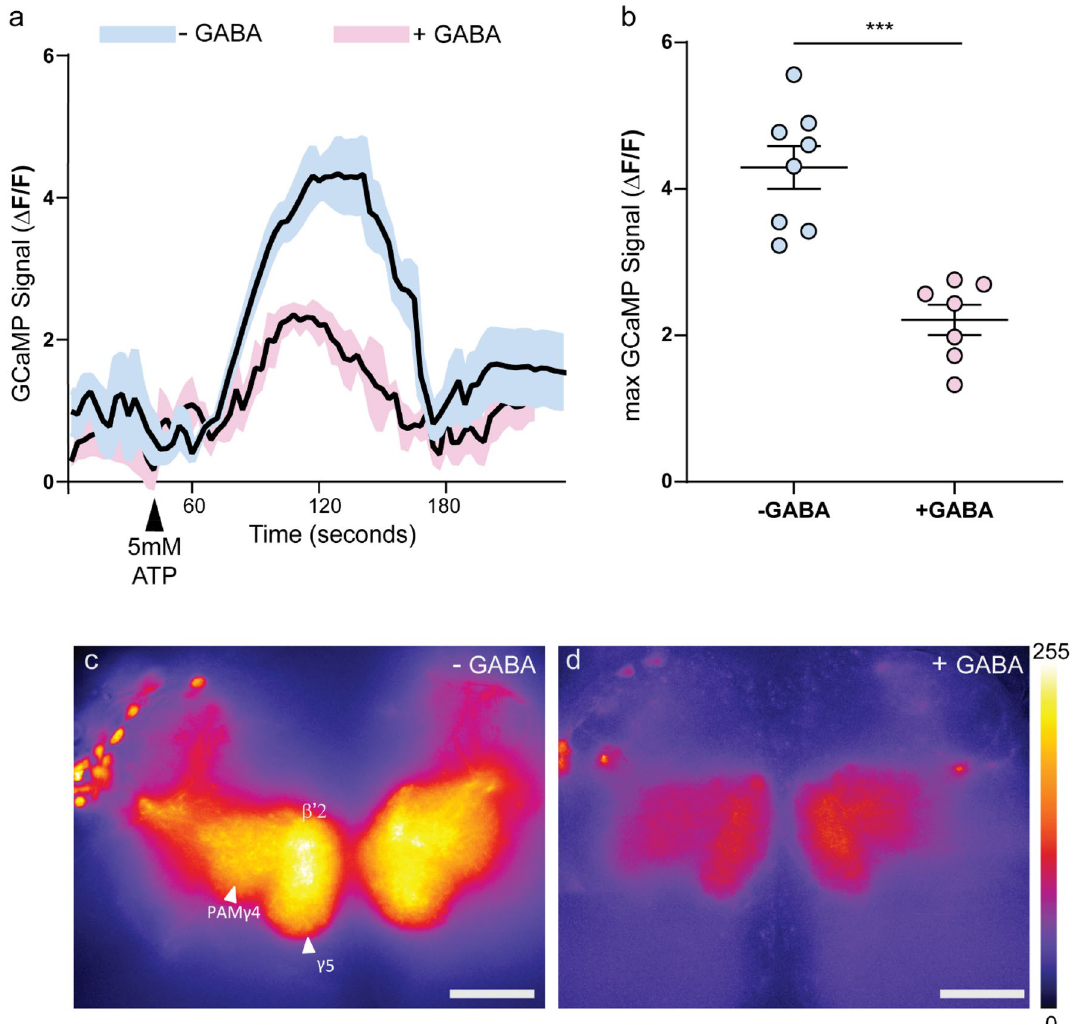
Figure 1. PAM-DANs required for wakefulness are GABA responsive. An ATP-gated cation channel P2X2 was expressed in PAM neurons using MB196B split-GAL4 line along with a calcium sensor GCaMP6m (196B > P2X2, GCaMP6m) to quantify ATP-induced changes in intracellular Ca 2+ levels as a readout of the neural excitability in presence and absence of GABA. Whole brains were dissected and imaged in HL3 buffer. ( a ) Time series of fluorescence images recorded to measure Ca 2+ signals. PAM-DANs were activated by bath application of 5 mM ATP (black arrow indicates ATP application). Brains were incubated with 50 mM GABA (+ GABA, pink) or in HL3 (−GABA, blue) 5 min prior to recording. Data represents mean and SEM (n = 7–8) of ΔF/F = (Ft − Fo)/Fo) where Fo = is defined as the average background subtracted baseline fluorescence for the ten frames preceding ATP application. ( b ) Maximum ΔF/F in the presence (pink) and absence of GABA (blue). Two conditions were compared by Unpaired t-test with Welch’s correction, two-tailed p value was < 0.0001. ( c , d ) Representative images indicating ROIs (PAM-DAN innervations in γ5, β ′ 2, and γ4 of MB lobes) used for comparison for Ca 2+ signals. Left panel (−GABA or no GABA) and right panel indicated recording in the presence of GABA. Scale bar indicated 10 μm and scale of fire LUT used to emphasize pixel intensity (0–255) is shown for